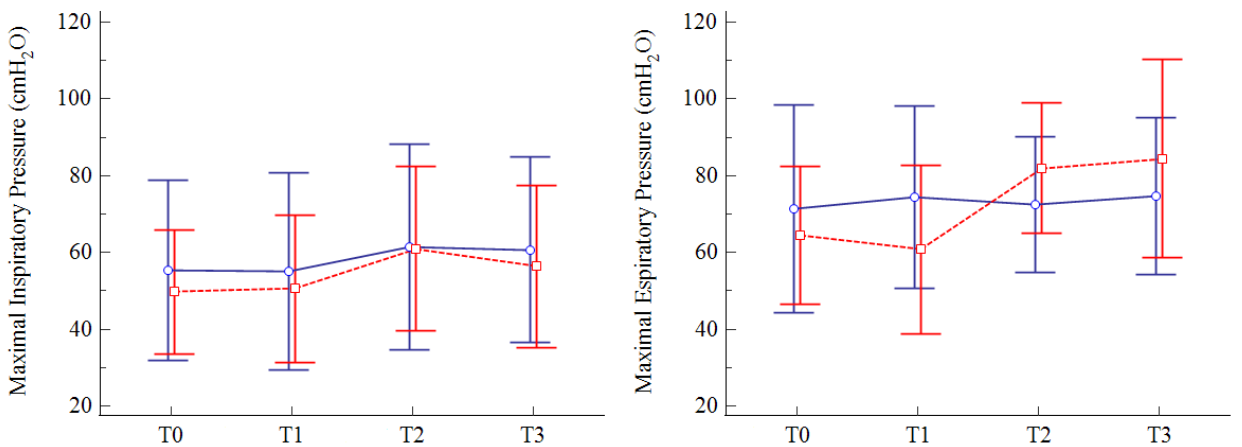
Figure 2. Distribution overtime for MIP and MEP values in the RMT group (red) and CON group (blue). Legend: data are reported as mean (95% confidence interval).